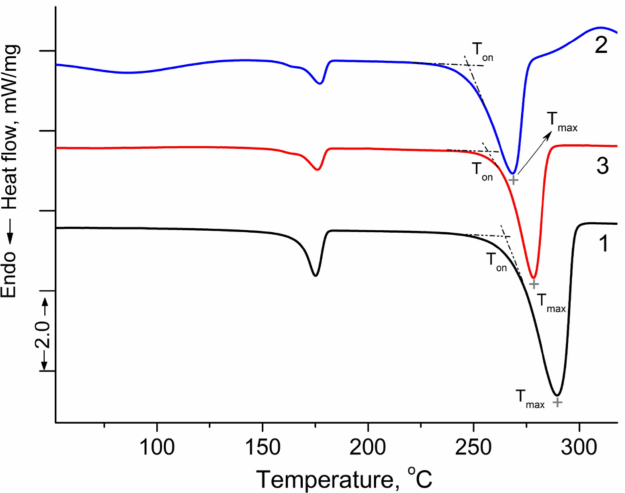
Figure 3. DSC heat flow curves of PLA (1), PLA–chitosan (50:50) wt. % composition (2) and PLA– chitosan (50:50) wt. % composition containing sorbed Fe 3+ ions (3), obtained by heating up to 400 ◦ C.